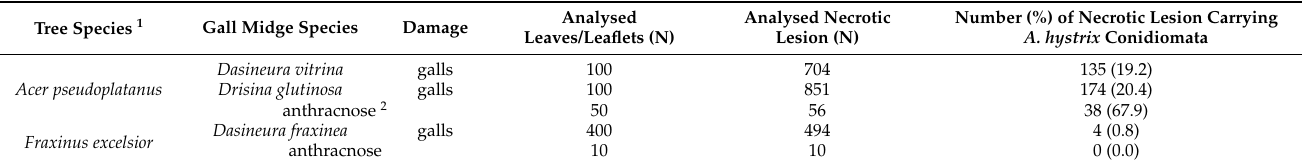
Table 1. Occurrence of Apiognomonia hystrix conidiomata in relation to gall midge species and within necrotic areas of Acer pseudoplatanus and Fraxinus excelsior leaves, analysed from 2012–2017. Damage Analysed Leaves/Leaflets (N) Analysed Necrotic Lesion